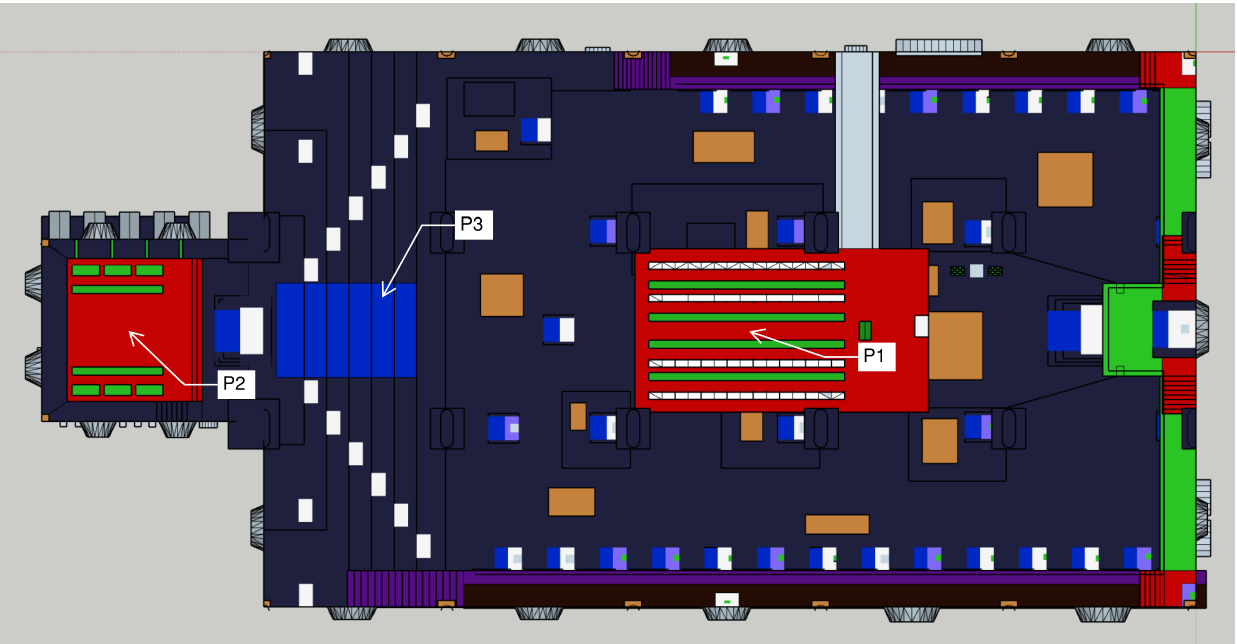
Figure 9. Top-down view of the digital reconstruction of the abbey. North is up in the figure. The monks’ choir is the red area to the left, and the nuns’ gallery is the red area in the center. Three source positions—P1, P2, and P3—are